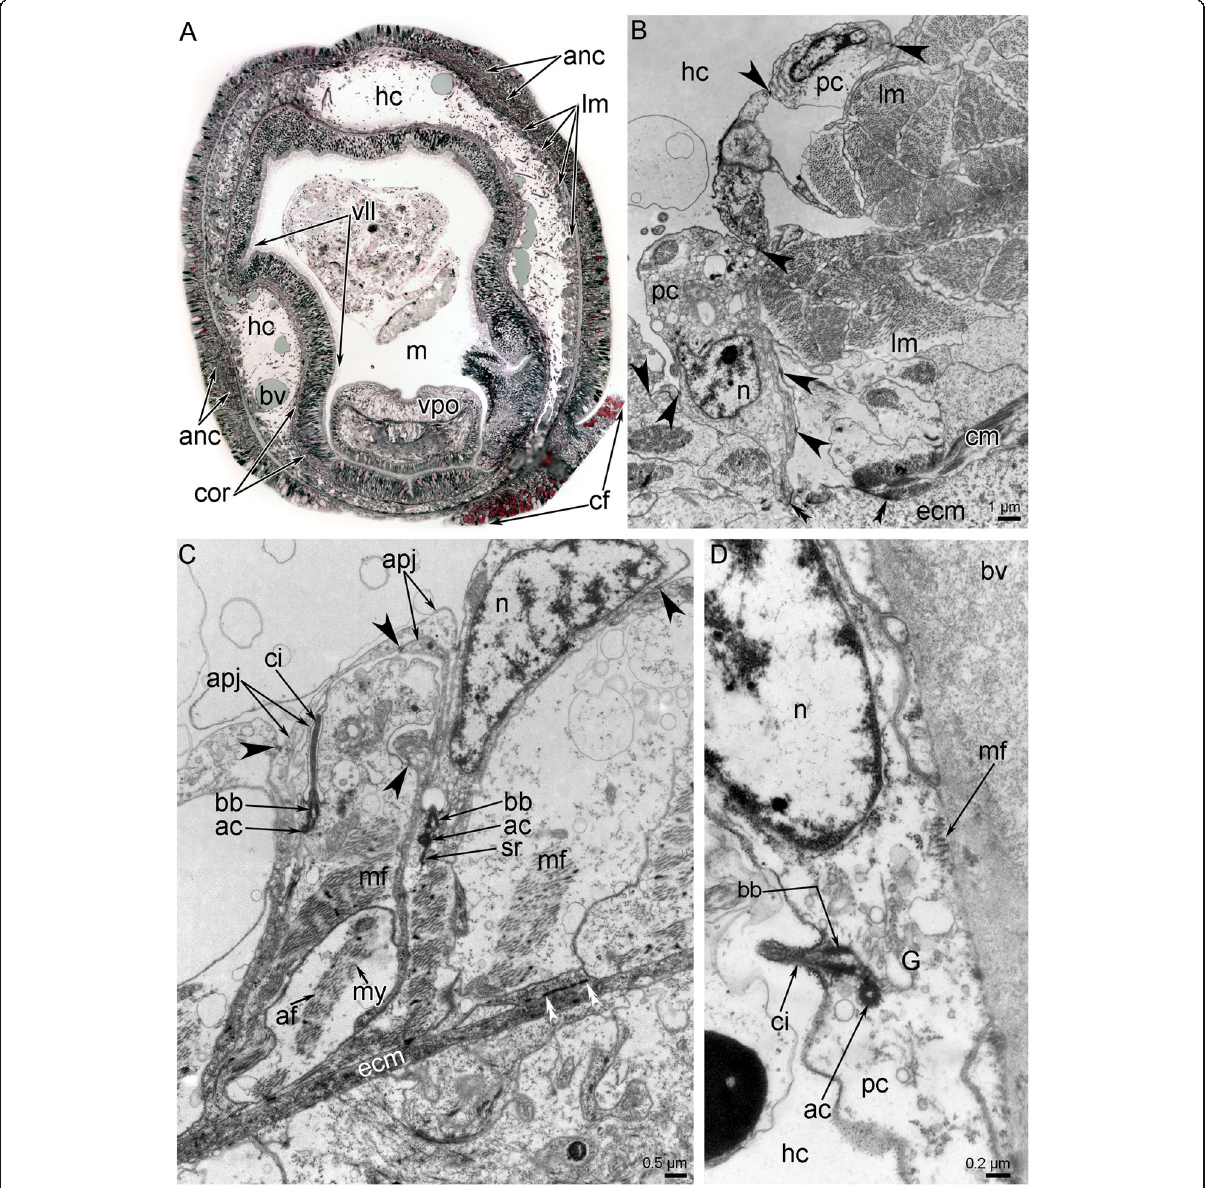
Fig. 6 Histology and ultrastructure of the coelom of the head of Owenia borealis . A Semi-thin transverse section of the head: the spacious head coelom is visible. B Ultrastructure of a part of coelomic lining, which is formed by alternating peritoneal and myoepithelial cells. Adherence junctions between cells are indicated by arrowheads. Hemidesmosomes are indicated by double arrowheads. C Coelomic lining, which is formed by monociliated myoepithelial cells. Adherence junctions between cells are indicated by arrowheads. Hemidesmosomes are indicated by double arrowheads. D A part of wall of blood vessel, which consists of monociliated myoepithelial cells. Abbreviations: ac – accessory centriole; af – actin filaments; anc – outer ring of the anterior nerve center; apj – apical projections of myoepithelial cells; bb – basal body; bv – blood vessel; ci – cilium; cf. – collar fold; cm – circular muscles; cor – circumoral nerve ring of the anterior nerve center; ecm – extracellular matrix; G – Golgi apparatus; hc – head coelom; lm – longitudinal muscle; m – moth; mf – myofilaments; my – myosin filament; n – nucleus; pc – peritoneal cell; sr – striated rootlet; vll – ventrolateral lip; vpo – ventral pharyngeal ventral blood vessel splits into two lateral efferent Blood vessels branches, which give rise to two prominent lateral blood Three-dimensional modelling revealed that the ventral plexuses (Fig. 5D). The dorsal blood vessel splits into and dorsal blood vessels give rise to numerous blood two lateral afferent vessels at the middle of the head vessels in the head and tentacles (Fig. 5D). At the border (Fig. 5D). In each tentacle, there are three longitudinal between the first trunk segment and the head, the